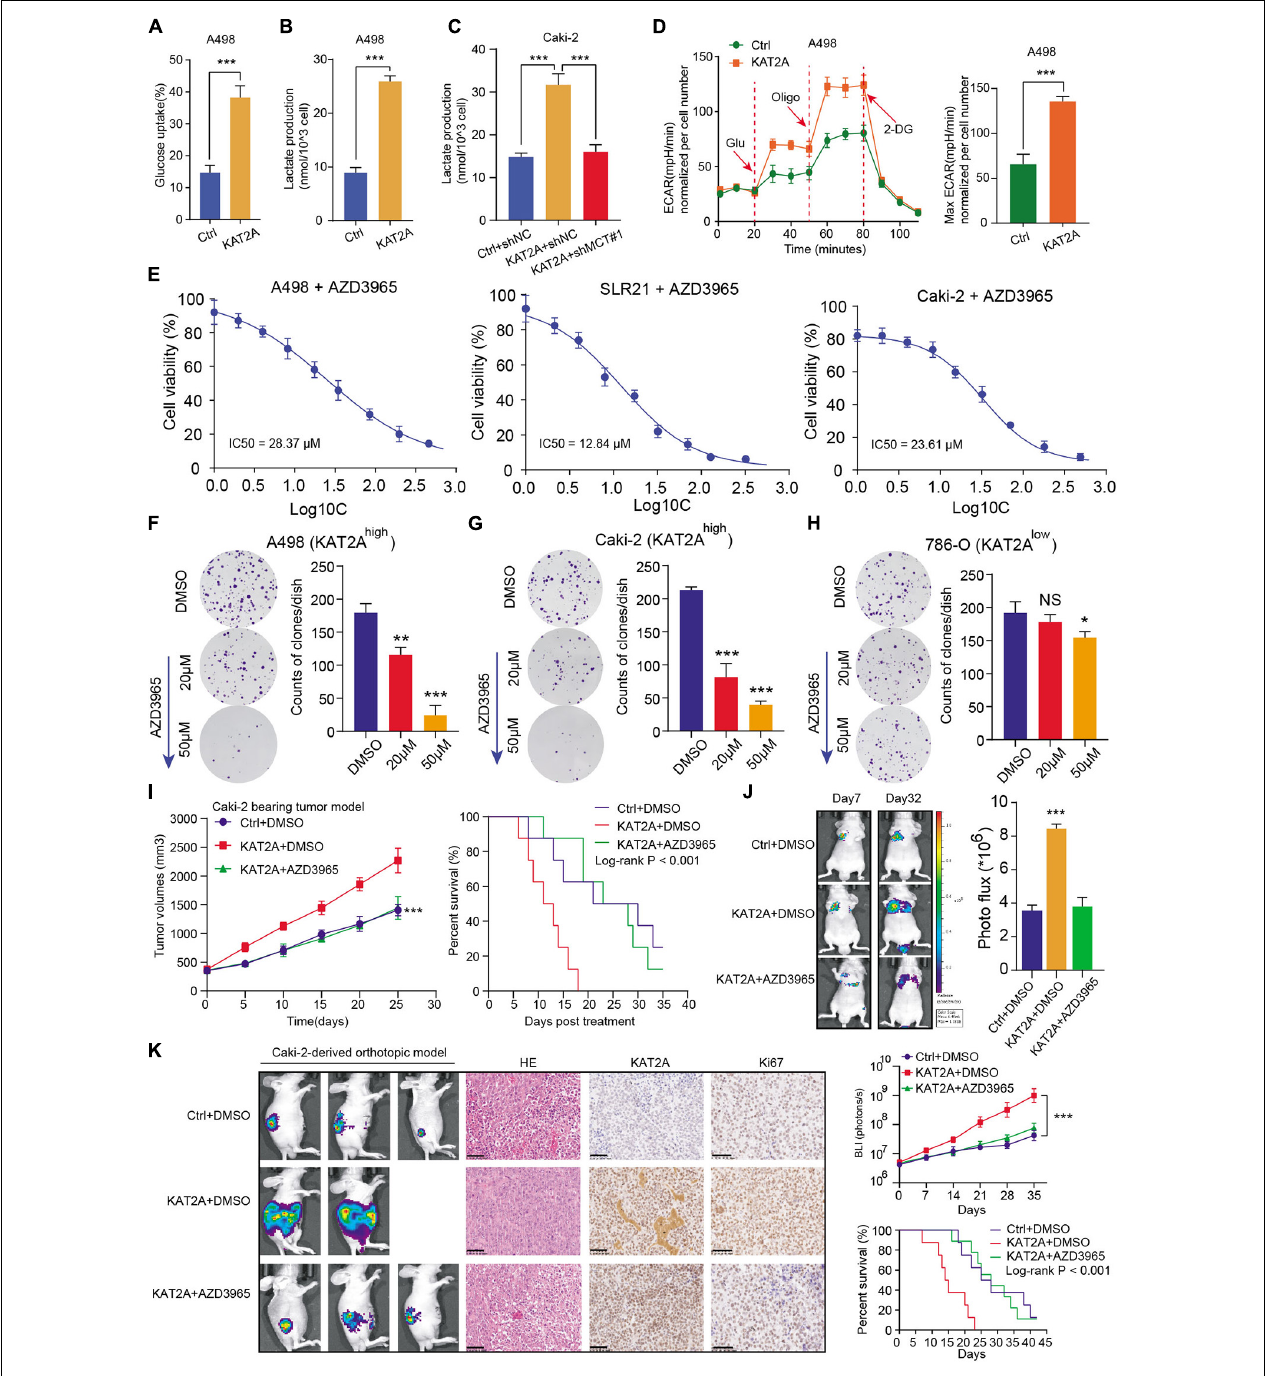
FIGURE 6 | MCT1 inhibitor (AZD3965) was effective to suppress tumor growth of KAT2A high RCC. (A,B) Overexpression of KAT2A induced glucose uptake and lactate production in A498 cells. (C) MCT1 knockdown inhibits lactate production in KAT2A-overexpressed Caki-2 cells. (D) The ECAR profile was assessed in KAT2A-overexpressing A498 with a Seahorse XF24 analyzer for 100 min. (E) Detection of IC50 of AZD3965 in three independent RCC cell lines (A498, SLR21 and Caki-2). (F–H) AZD3965 could significantly inhibit the colony formation in KAT2A high cell lines (A498 and Caki-2) in a dose-dependent manner, but hardly work in 786-O. (I) Detection of tumor volumes and survival outcomes of mice in three groups, including Ctrl + DMSO, KAT2A + DMSO, and KAT2A + AZD3965. (J) AZD3965 could effectively inhibit the distal metastatic ability of KAT2A-overexpressing Caki-2 via tail vein injection, as indicated by Photo flux signals (left). (K) Representative pictures of Caki-2-derived renal orthotopic xenografts in three groups, as indicated in the left panel ( n = 5 per group). Representative diagrams of H&E slides and matched staining scores of KAT2A and Ki67 (middle). Quantification of the serial photon flux signals in indicated tumor regions and prognostic difference of mice from three groups (right). * P < 0.05, ** P < 0.01, and *** P < 0.001.